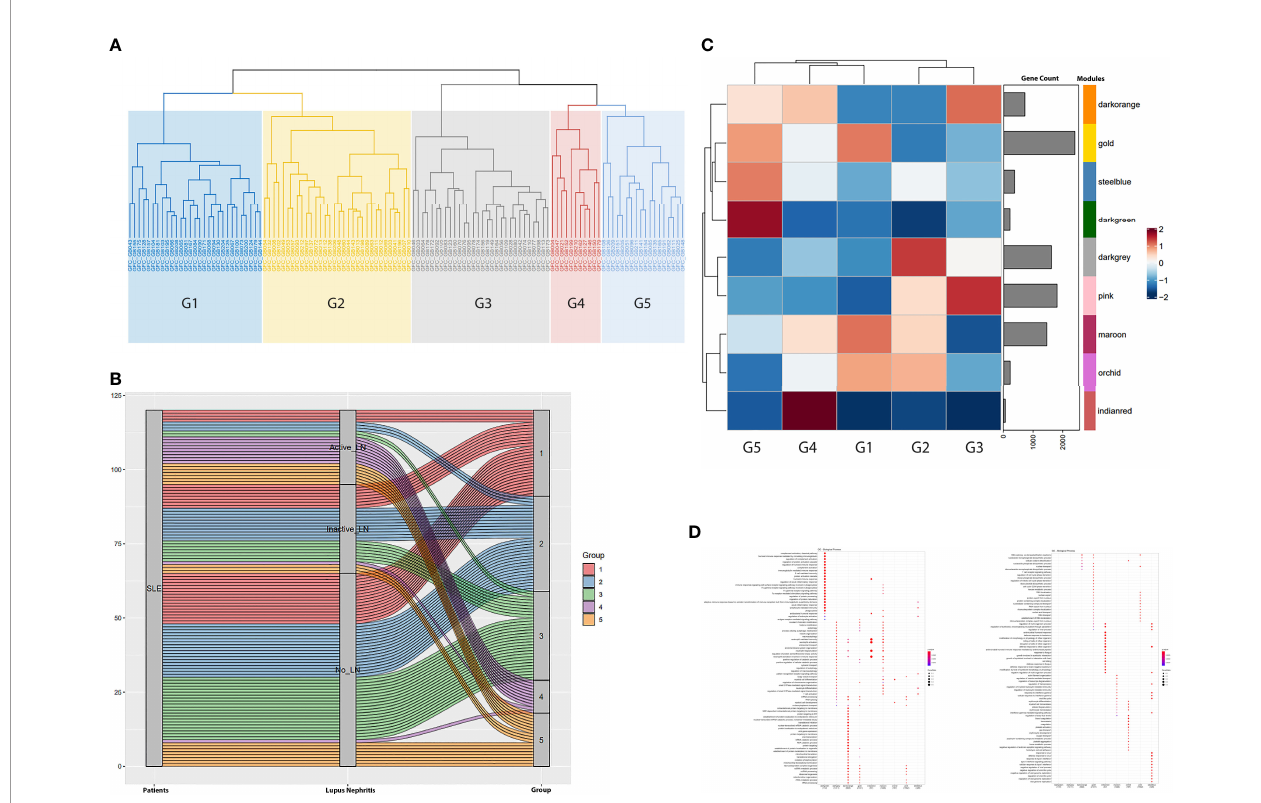
FIGURE 1 | (A) Hierarchical clustering of the samples based on the magnitude of the expression of each gene module (identi fi ed in Figure S1 ) de fi ned fi ve groups of patients (G1 to G5). Brie fl y, the x-axis demonstrates the patients analyzed in our study. GFC denotes the Group Fold Changes (de fi ned in Figure S1 ); GB denotes the sample; the number after the GB acronym denotes each patient database ID. (B) Alluvium plot illustrating the distribution of the SLE patients into the patient groups G1-G5 generated after the hierarchical clustering of the samples according to each module ’ s group fold changes. Brie fl y, the 120 SLE patients included in our study are displayed in the left vertical box (Patients). Each horizontal block corresponds to a patient. The distribution of the patients according to the presence and the activity of Lupus Nephritis (LN) was demonstrated in the middle vertical box. The distribution of the patients into the fi ve CoCena2 analysis de fi ned patient groups was shown in the right vertical box. (C) Heatmap showing the mean of the GFCs of the CoCena2 analysis derived gene modules in each one of the previously de fi ned patient groups. Group speci fi c GFCs demonstrated similar and counteracting gene expression patterns among patient groups. Brie fl y, increased expression of the indian-red module characterized G4. Enrichment of the dark-green module de fi ned G5. Heightened expression of the dark-grey module distinguished G2. Lastly, enrichment of the pink and dark-orange modules was indicative of G3. (D) Dot plot displaying the functional enrichment analysis of the CoCena2-derived modules. Gene modules are shown on the basis of the graph. Enriched gene ontologies and pathways are shown on left side of the graph. Brie fl y, the indian-red module included genes that were mainly enriched in neutrophil activation and degranulation. Functional enrichment analysis of the dark-green module revealed disturbances related to plasmablast-mediated responses. Dark-grey module predominantly consisted of genes related to autophagy. Genes of the pink module were enriched in mRNA splicing, whereas gene ontologies related to mitochondrial function were overrepresented among the genes included in the dark- orange